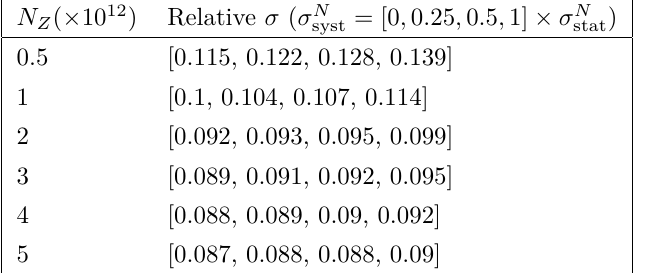
→ τ + ν τ ) as a function of N Z , where four different c